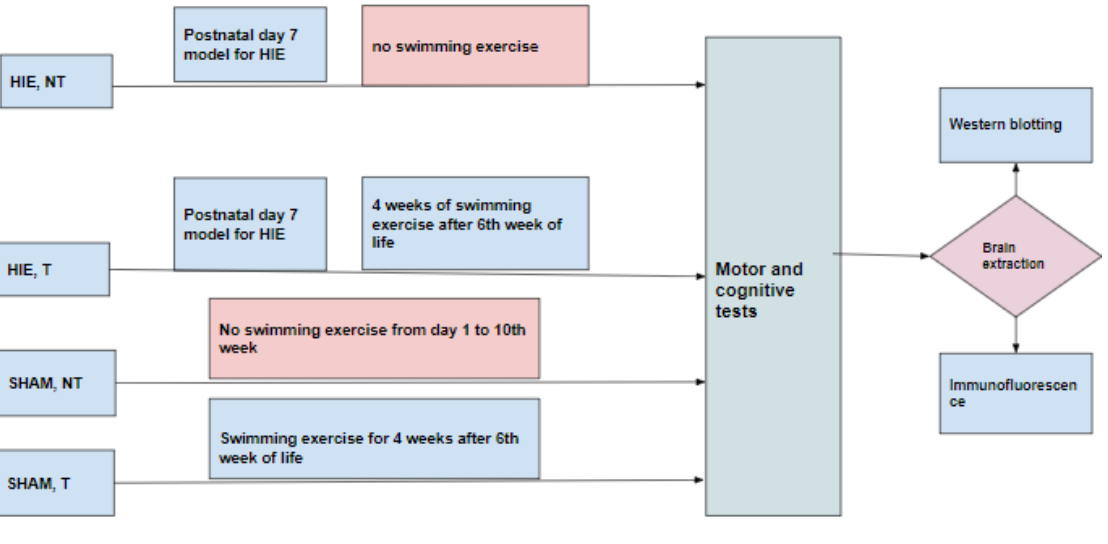
Figure 8. Experimental design .